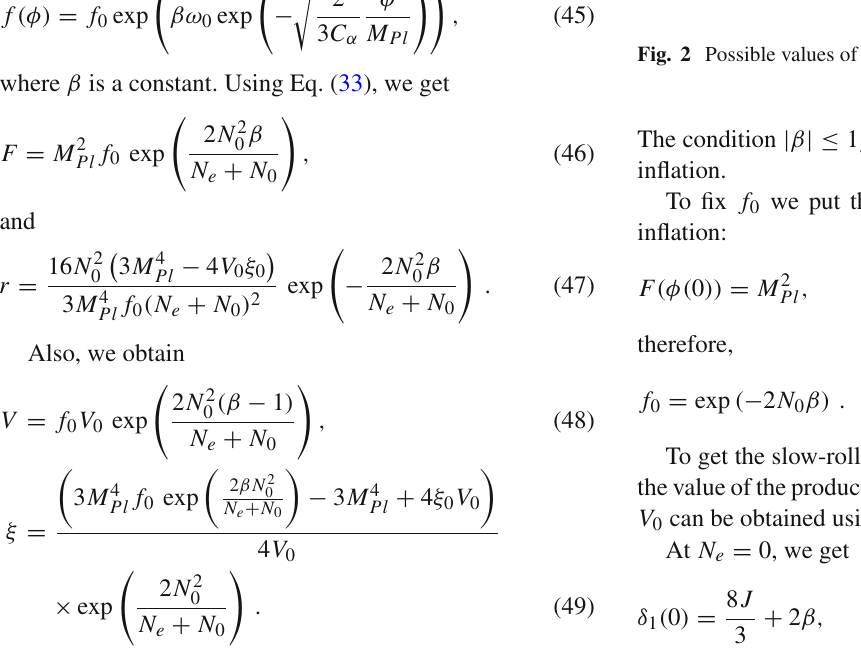
Fig. 2 Possible values of parameters J and β are in green domain